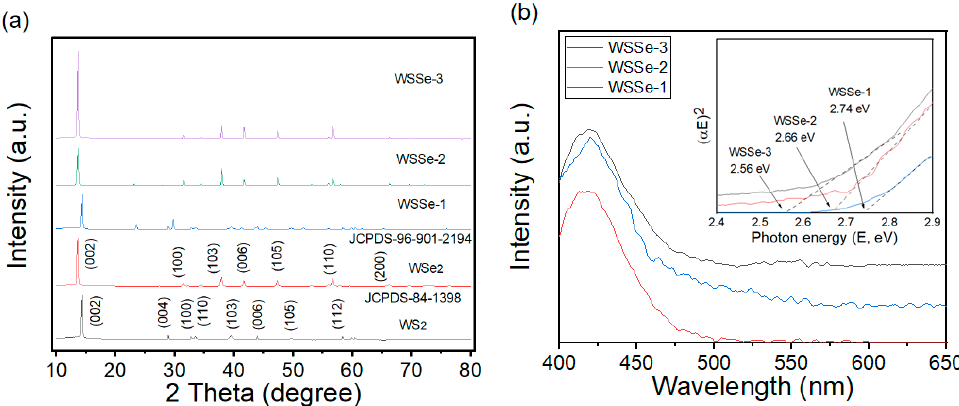
Figure 1. ( a ) XRD patterns of the as-prepared samples; ( b ) UV–vis spectra of WSSe-1, WSSe-2, and WSSe-3 samples; plots of ( α h υ ) 2 versus h υ for the bandgap energies of the photocatalysts in the inset.